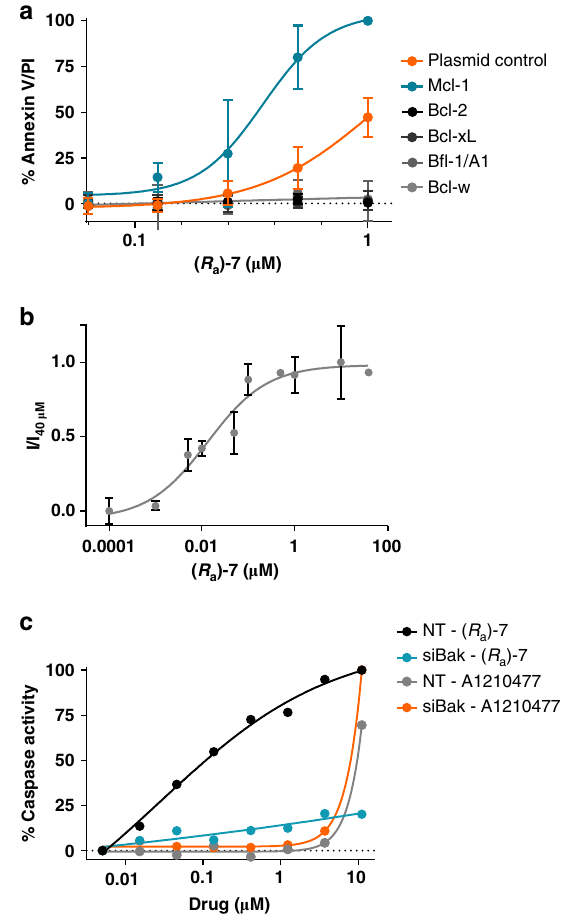
Fig. 3 ( R a )- 7 induces on-target intrinsic apoptosis. a Apoptosis induction in E μ -Myc lymphoma cells stably expressing human Mcl-1, Bcl-2, Bcl-xL, B fl -1/ A1, or Bcl-w and treated with ( R a )- 7 for 24 h. Data are shown as mean ± SD ( n = 3). b Isothermal dose – response curve of Mcl-1 at 48 °C plotted against varying concentrations of ( R a )- 7 . I/I 40 μ M : ratio of the signal intensity for each particular sample to the signal intensity obtained with ( R a )- 7 at 40 μ M. Data are shown as mean ± SD ( n = 3). c Caspase-3/7 activity in NCI- H23 cells treated with siRNA targeting Bak mRNA for 72 h before treatment with ( R a )- 7 for 6 h. Representative data of two independent